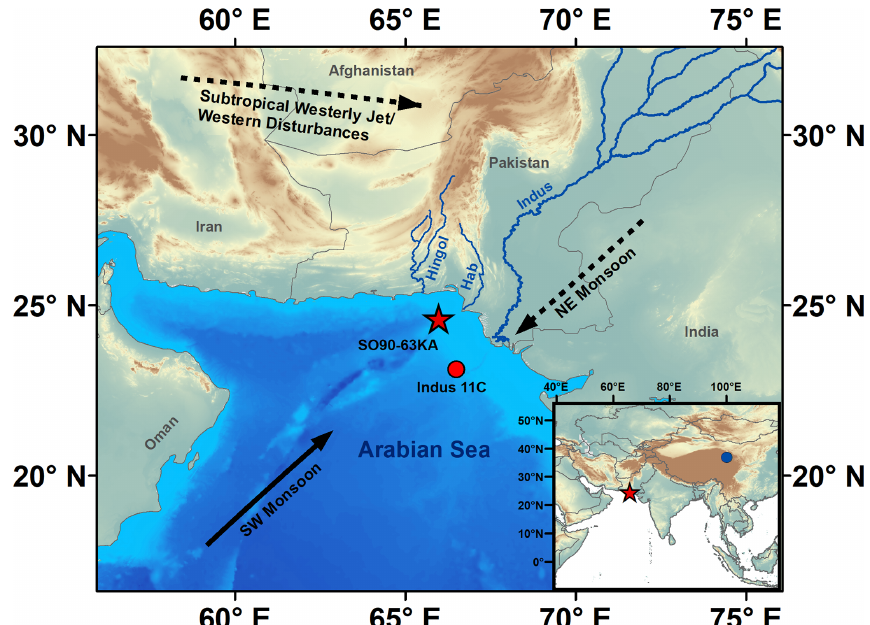
Figure 1. Location of the study site SO90-63KA (red star), the nearby record Indus 11C (Giosan et al., 2018) (red circle) and Lake Qinghai (Hou et al., 2016) (blue dot in the inset map). The rivers (blue lines) important for the study site are shown. The prevailing wind pattern during the summer monsoon, here indicated as southwest (SW) monsoon, is shown with a black arrow. The prevailing wind pattern of the winter monsoon, here indicated as the northeastern (NE) monsoon as well as the subtropical westerly jet and its associated rain bearing western disturbances, are shown as black dashed arrows. The map was created using ArcGIS v.10.8 (ESRI, 2019). The bathymetric data are from the General Bathymetric Chart of the Oceans (GEBCO, 2014; http://www.gebco.net, last access: 4 January